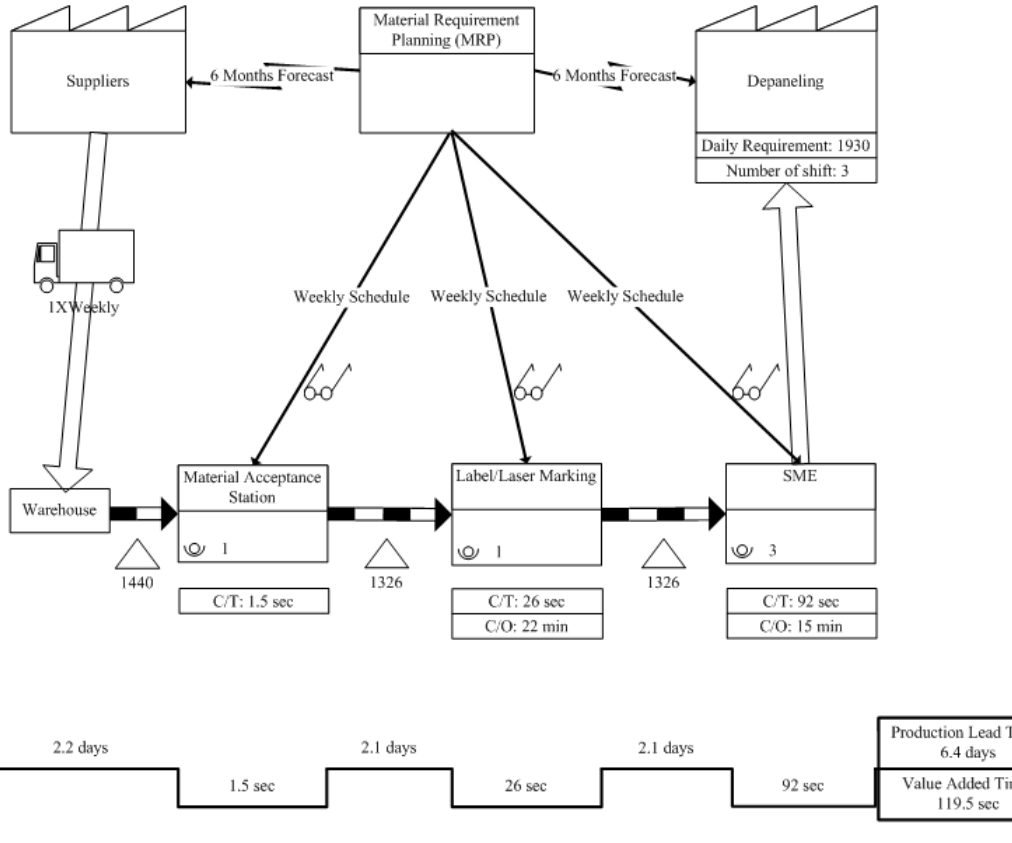
Figure 3. Future-state